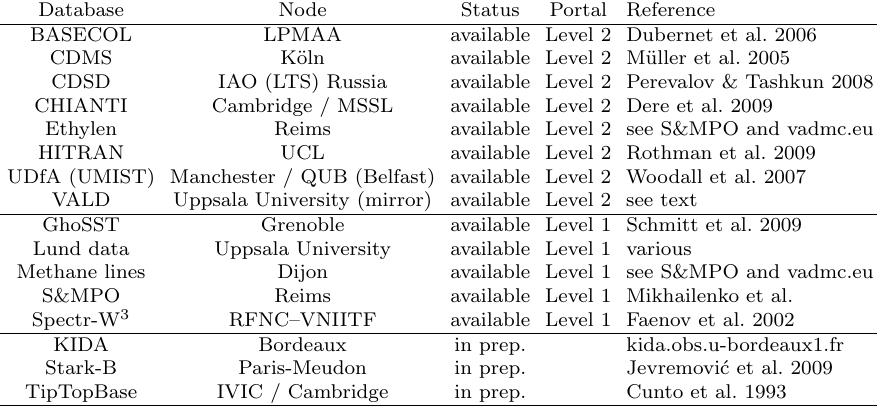
Table 1. Databases accessible through the VAMDC Level 2 Release registry browser. Further information include the VAMDC node hosting the database, and its availability (all databases including those in preparation (in prep.) will become accessible at the most recent portal level). References to the original description are listed in column